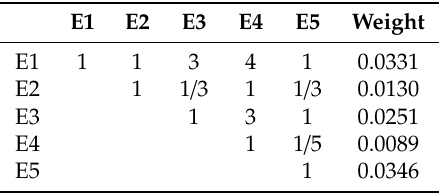
Table A2. Pairwise comparison matrix of Environmental Pressure.